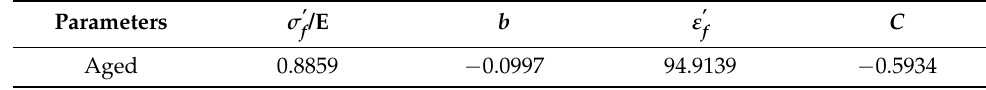
Figure 9. Comparison between the experimental and the predicted LCF life.